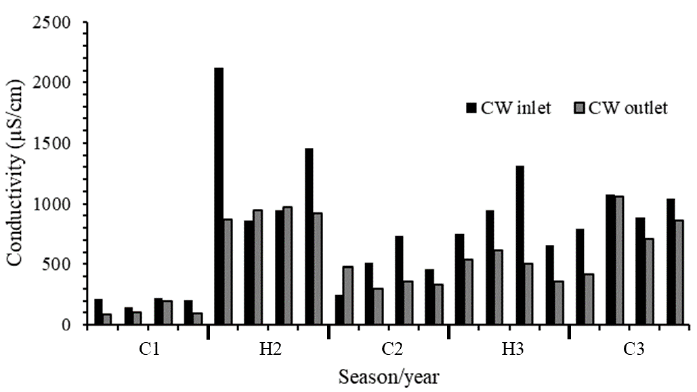
Figure 3. Constructed wetland inlet and outlet water conductivity (µS/cm) for different seasons (cold—C and hot—H) and years (1, 2, and 3).